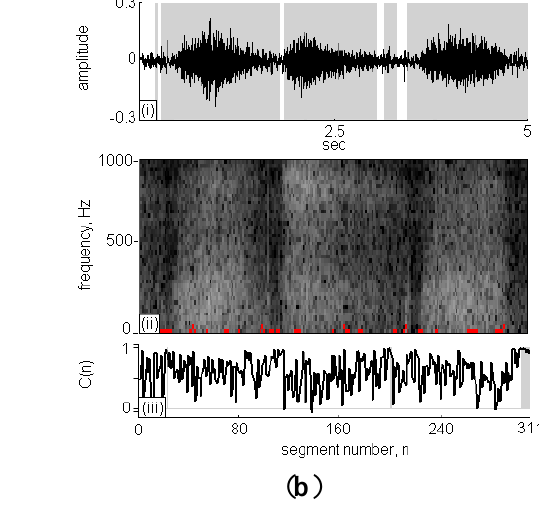
Figure 5. Two respiratory sounds collected from websites analyzed by RSACC and TF-WD ( a ) concerns the case No. 11 of wheeze cases set and ( b ) concerns the case No. 1 of non-wheeze cases